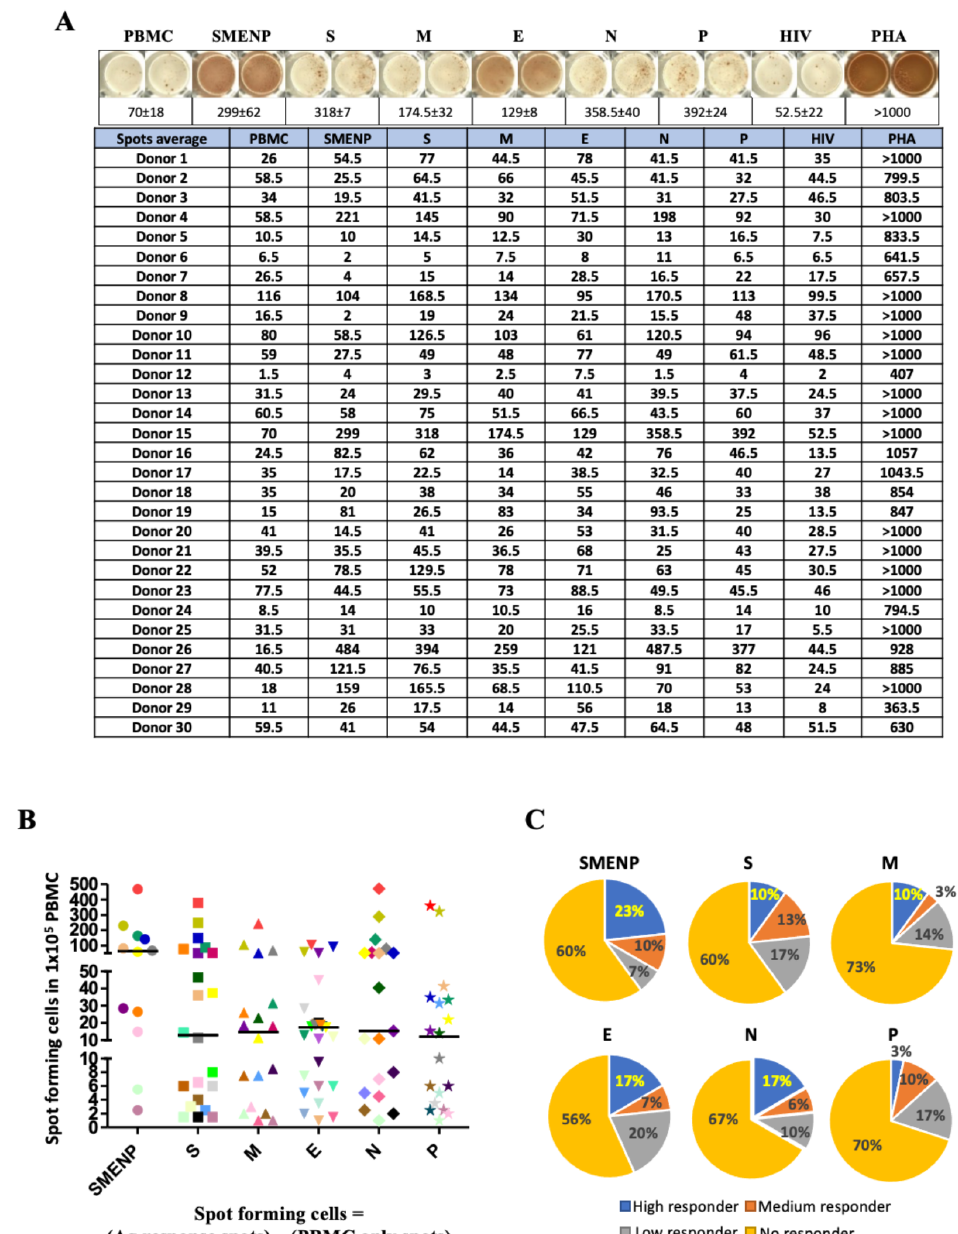
Figure 2. SARS-CoV-2 specific T-cell precursor frequencies in healthy subjects. ( A ) IFN- γ ELISPOT assay. PBMCs of 30 healthy subjects were activated in vitro with individual or pooled S, E, M, N, and P peptide mixes, and IFN- γ reactive cells were detected. PHA activated T cells were used as positive controls. The HIV-1 Pol peptide pool was included as background control as all donors were HIV-1-negative. The group (PBMC) without antigen stimulation was also included as background control. Representative ELISPOT wells are shown on top, and the machine-documented spot numbers listed below were the mean values of duplicates for all 30 donors. ( B ) The number of spot-forming cells after background subtraction per indicated target antigens (below the background levels were shown as 0). Each symbol represents a peptide pool, and different colors represent different subjects. The bar represents the median response value of all subjects to each antigen peptide pool after deducting the background value. ( C ) Pie graph illustration of the diverse individual cellular immune response to the different viral antigens based on fold of increase of spot forming cells. The color classification of individual response illustrates different ranges of IFN- γ specific spots: high responder, >3 fold of increase in spots; medium responder, 2–3 fold of increase; low responder, 1.5–2 fold of increase; and no responder, <1.5 fold of